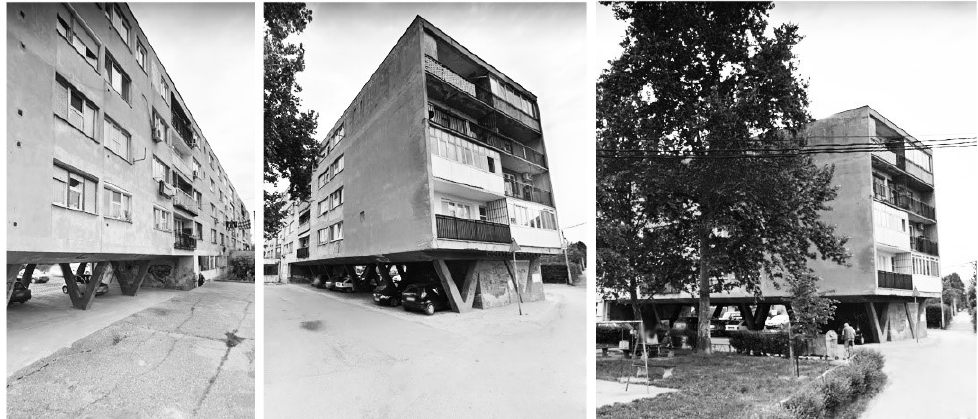
Figure 7. Photographs of a lamella realized in the residential area. Source: Authors.